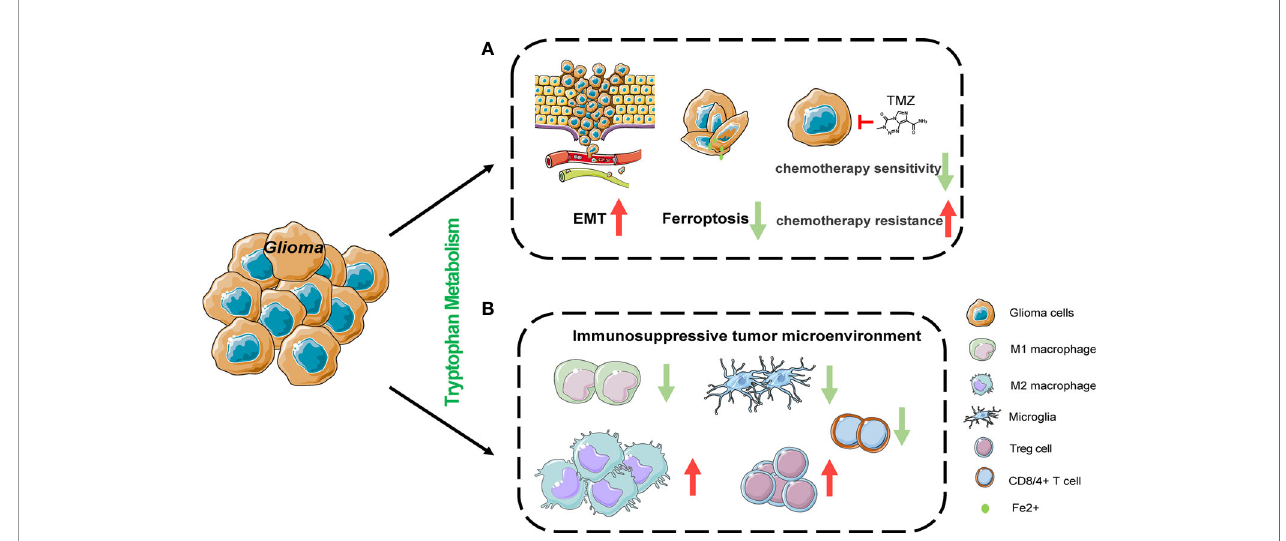
FIGURE 2 | The effects of tryptophan metabolism in cancer cell and its microenvironment. (A) Tryptophan metabolism mediated by IDO1 and TDO could promote the migration and invasion of glioma cells via Kyn/AHR signaling pathway. IL4I1 catabolizes tryptophan into indole-3-pyruvate (I3P) to inhibit ferroptosis by expressing anti-oxidative gene expression program in Hela cells. IDO1 is induced as an undesired effect of chemotherapy in non-small-cell lung cancer and breast cancer. (B) Tryptophan metabolism suppresses T cell proliferation and function by inducing the differentiation of regulatory T cells (Tregs), the expression of programmed cell death protein 1 (PD1) on CD8+ T cells, cell death of CD8+ T cells and the recruitment of immunosuppressive tumor-associated macrophages. EMT, epithelial- mesenchymal